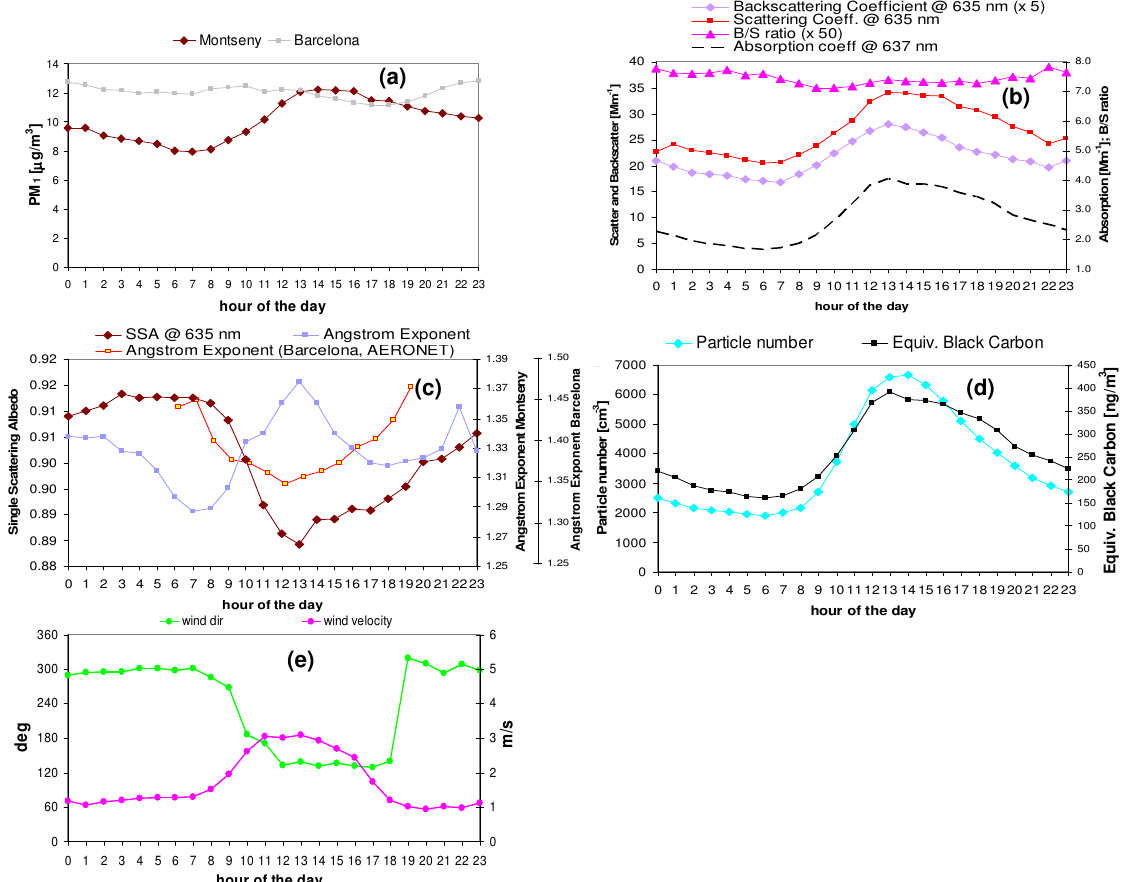
Fig. 8. Diurnal cycles for: (a) PM 1 (Montseny and Barcelona), (b) scattering coefficient (635nm), hemispheric backscattering coefficient (635nm), absorption coefficient (637nm), backscattering-to-scattering ratio (B/S), (c) ˚Angstr¨om exponent and Single Scattering Albedo (SSA) at 635nm at Montseny and ˚Angstr¨om exponent from AERONET data at Barcelona (red line); (d) equivalent black carbon and particle number concentrations, and (d) wind speed and